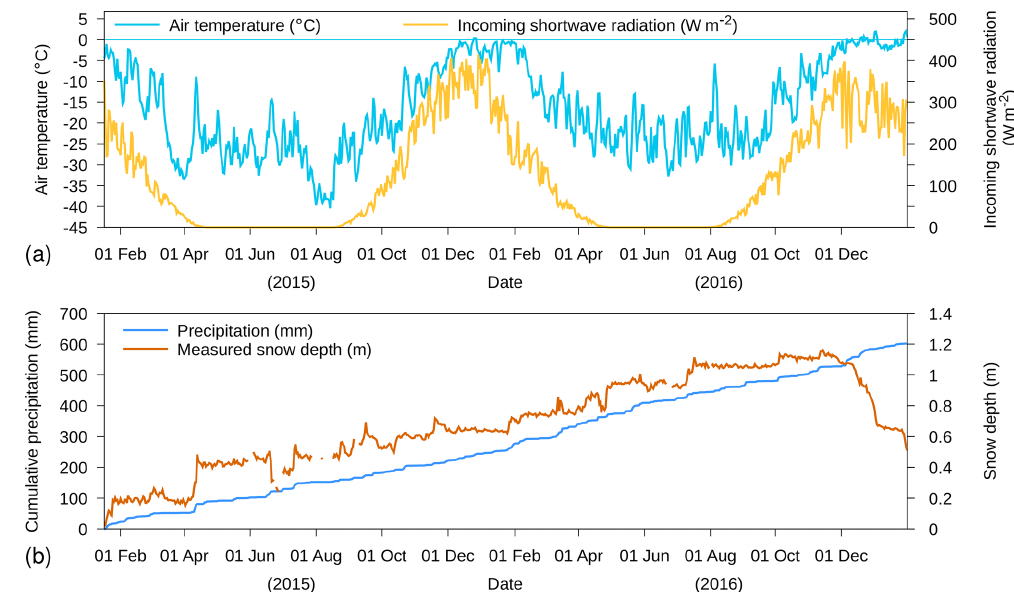
Figure 2. Meteorological forcing data from ERA5 for snow buoy 2014S12 for (a) daily average air temperature and daily average incoming shortwave radiation and (b) cumulative precipitation. In (b) , measured snow depth by the buoy is also shown.